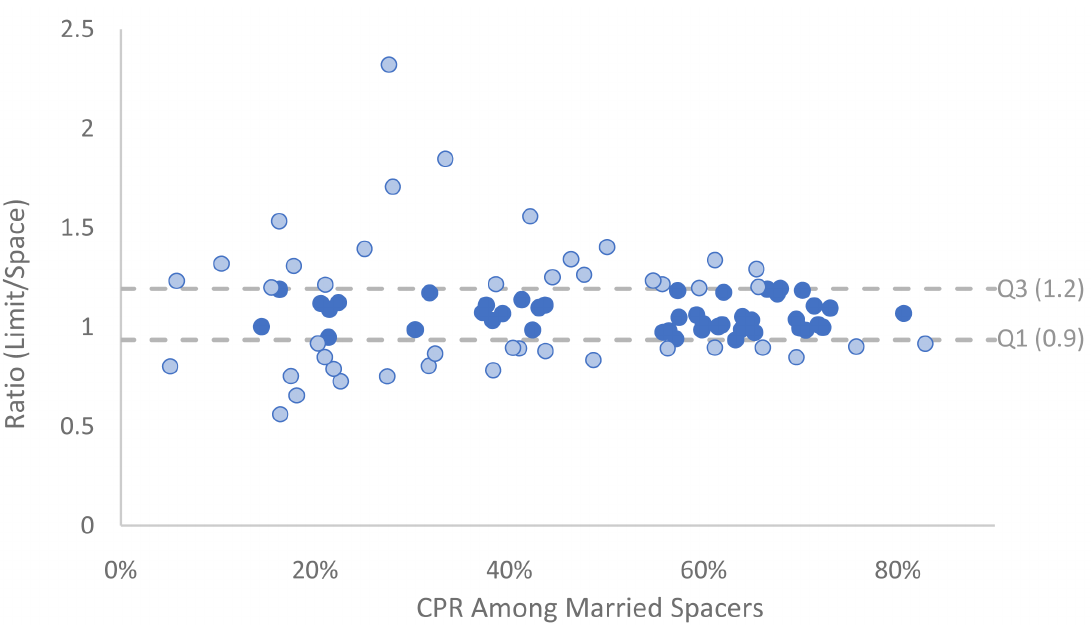
Figure 4. Ratio of married CPR: limit/space by CPR among married spaces. This graph shows data from recent surveys, showing the contraceptive prevalence rate (CPR) among married spacers compared to the ratio of CPR between women who want no more children (limiters) and those who wish to space. The dotted lines indicate the interquartile range (IQR). Light blue dots are outside of the